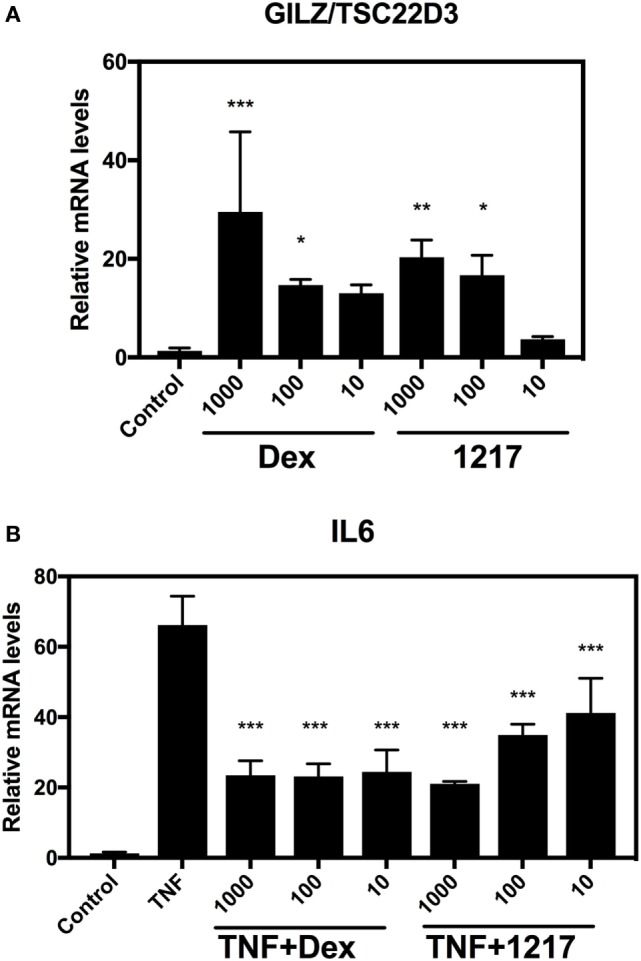
Selective glucocorticoid receptor agonist GSK866 analog UAMC-1217 elicits glucocorticoid receptor selective downstream anti-inflammatory effects at endogenous target genes. (A) QPCR assays was performed against the GR target gene GILZ/TSC22D3 in HaCat cells treated for 6 h with different concentrations 10, 100 or 1,000 nM Dex or UAMC-1217. Bar graph plot represents the relative mRNA levels of GILZ/TSC22D3 upon Dex or UAMC-1217 treatment. (B) QPCR assays was performed against the TNF-inducible inflammatory gene interleukin-6 (IL6) in HaCat cells treated for 6 h with different concentrations 10, 100, or 1,000 nM Dex or UAMC-1217 either or not, cotreated for the last 4 h with TNF (2,500 IU/ml) as indicated in panel (B). All the qPCR assays have been normalized to the GAPDH mRNA housekeeping gene. Bar graphs represent relative mRNA (mean ± SD) levels of three replicates. Significant mean differences versus control setups panel (A) or TNF treated setup panel (B) are marked as *** (P < 0.001), **(P < 0.01), * (P < 0.05) and were determined by one-way ANOVA (Dunnetts Posttest).